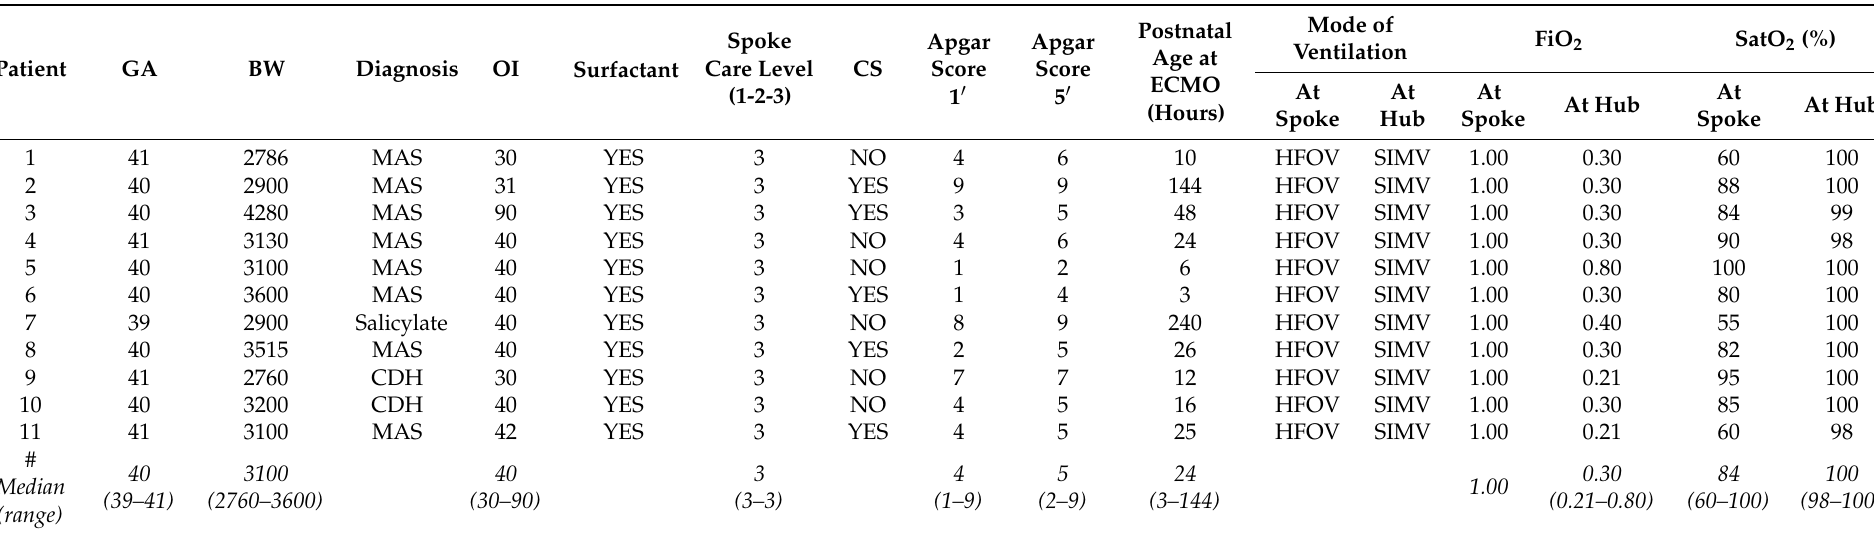
Table 2. Patients characteristics at Hub and Spoke (HandS) ECMO implantation, and modes of ventilation before (at the spoke) and after (at the